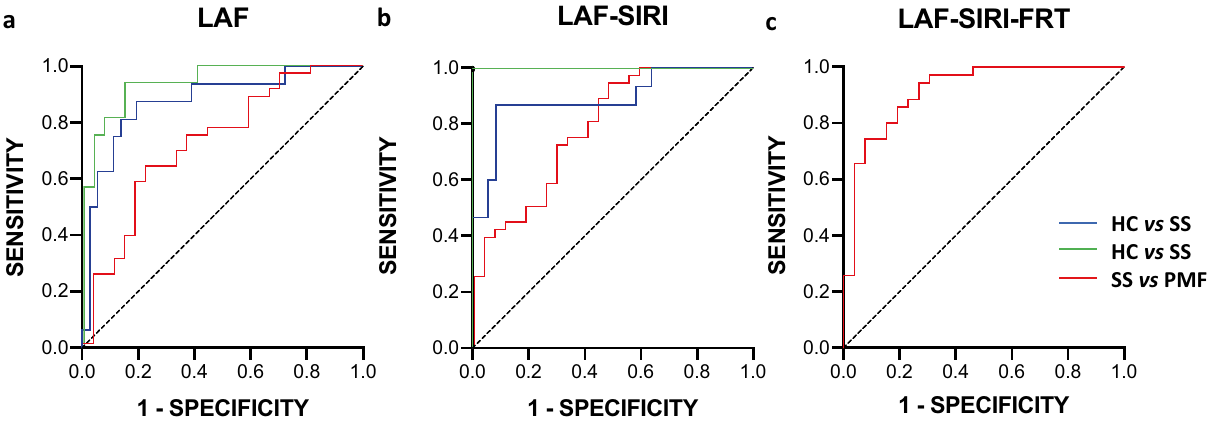
Figure 4. Combined ROC curves for a multiple logistic regression analysis with several markers. ( a ) LAF (LDH-ACE-fibrinogen), ( b ) LAF-SIRI, ( c ) LAF-SIRI-FRT (LAF-SIRI-FVC-DLCO). Note that LAF-SIRI-FRT could only be tested between patient